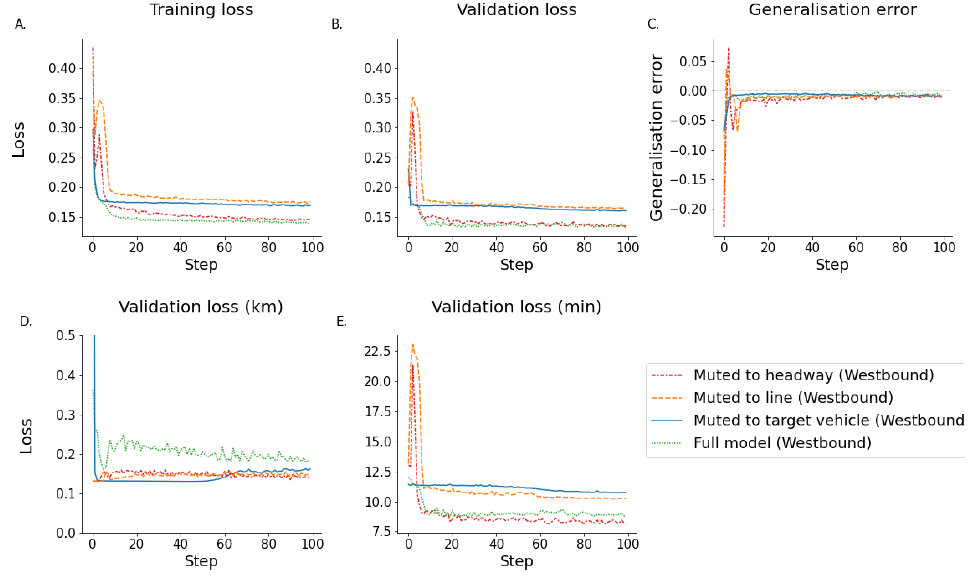
Figure 12. Training and validation of the eastbound direction for all muted models in comparison to the model with access to the entire network data. In the example of this direction the best validation loss was achieved by the model incorporating the entire network data. ( A ) shows the training loss. ( B ) shows the validation loss. ( C ) shows the generalisation error calculated by subtracting the training error from the testing error. ( D ) shows the estimated validation error in km. ( E ) shows the estimated validation loss in minutes. (Note that subfigure ( D ) has a truncated y axis for illustration purposes).